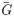
Results of the application of Virtual Twins with as outcome Social Skills Rating System (SSRS).The ellipses in the figure represent the internal nodes containing the split variables, with below each ellipsis the corresponding split point. The upper ellipsis represents the root node corresponding to the complete group of children. The rectangles represent the leaves of the tree, that is, the final subgroups of children; each rectangle contains the sample size of the corresponding subgroup (N), and the mean estimated individual differential treatment effect (G¯). The leaves in which the estimated individual differential treatment effect exceeds the threshold c = 0.43) are represented by solid rectangles. It should be noted that after post-processing of the results, it appears that there is insufficient evidence that the subgroups in these leaves have a significantly better outcome on SSRS compared to the total group of children. Subgroup estimated treatment effect was 1.39 (d = 0.44). Total group estimated treatment effect was 0.69 (d = 0.23).